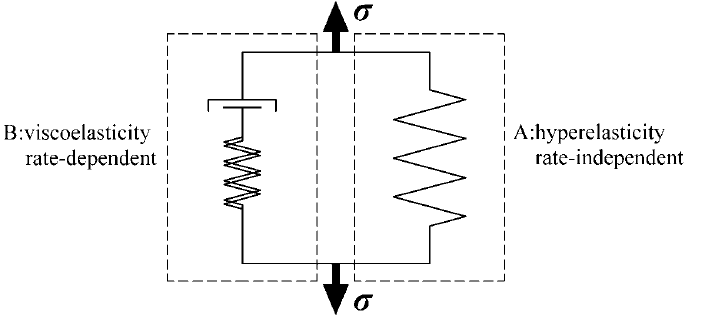
Figure 5. Parallel mechanical response of part A and B.